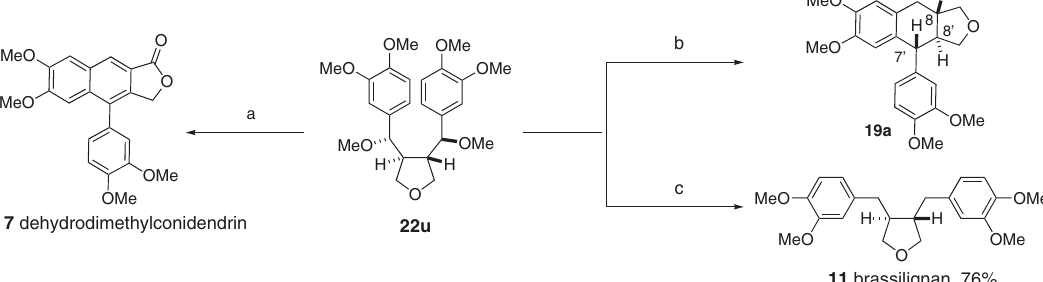
Fig. 6 Lignan interconversion. Reagents and conditions: (a) DDQ, TFA, DCM, RT, 24 h, 73% yield; (b) Et 3 SiH, BF 3 (cid:129) Et 2 O, 94% yield, dr = 11:1; (c) PdCl 2 (10 mol%), PMHS, MeOH, 40 °C. Yields refer to isolated pure product.